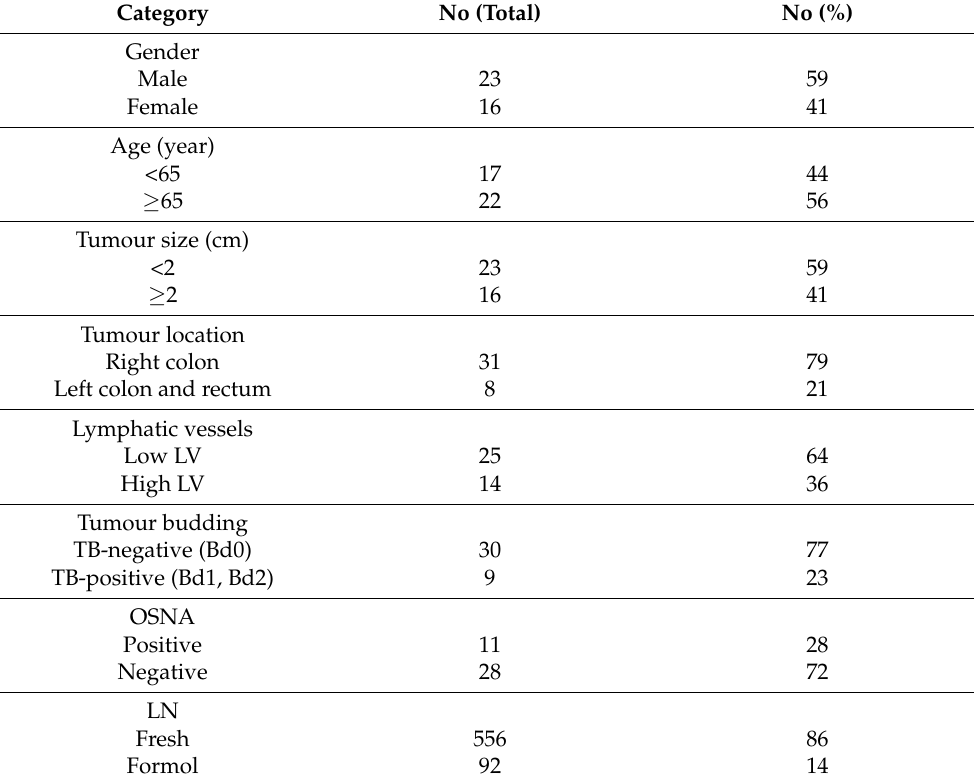
Table 1. Clinical and pathological characteristics of in situ colorectal